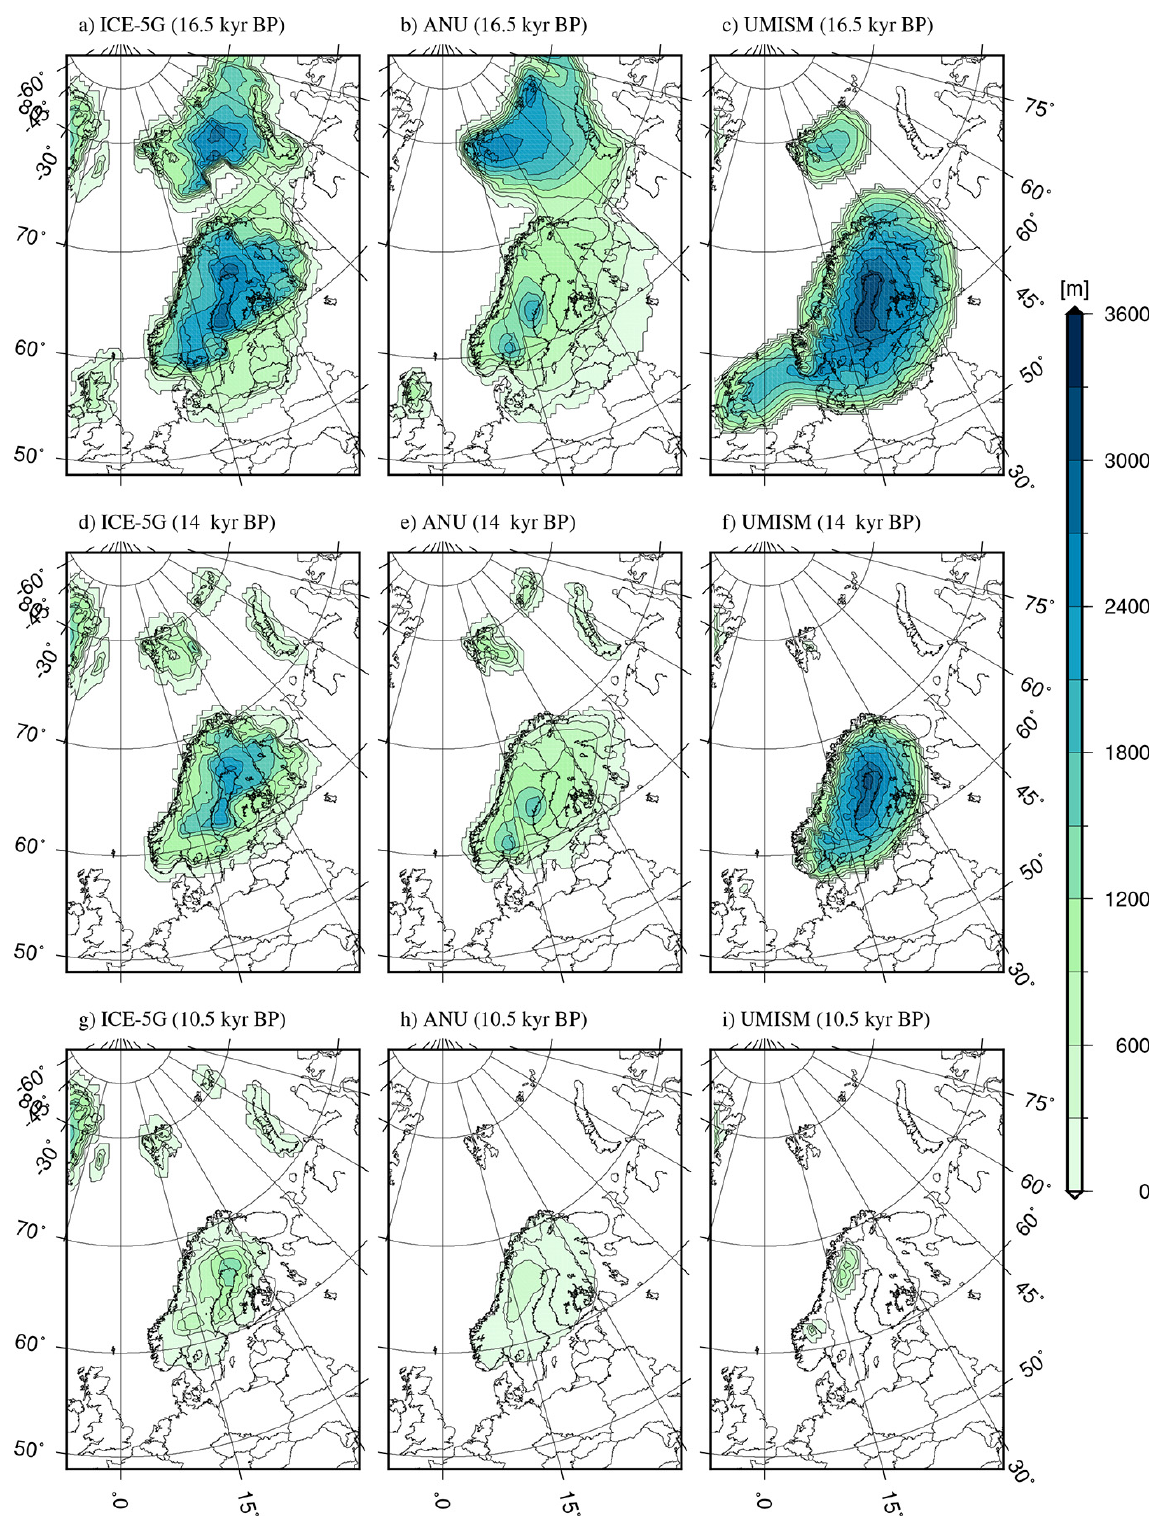
Figure 4. Ice sheet extent and thickness at 16.5kyrBP (a–c) , 14kyrBP (d–f) and 10.5kyrBP (g–i) for ICE-5G ( a , d and g ), ANU ( b , e and h ) and the UMISM model ( c , f and i ). Note that the ANU model at 10.5kyrBP has been generated by linear interpolation in thickness between the solution at 10910 and 10274yrBP, the extent of the ice sheet is inherited from 10910yrBP, while the ice sheet displayed at 14kyrBP is the snapshot at